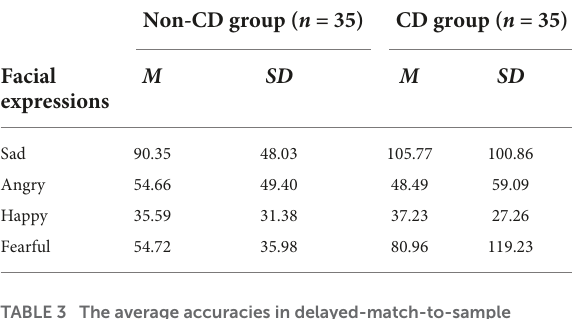
TABLE 3 The average accuracies in delayed-match-to-sample (DMTS) task (%). Non-CD group ( n = 35)